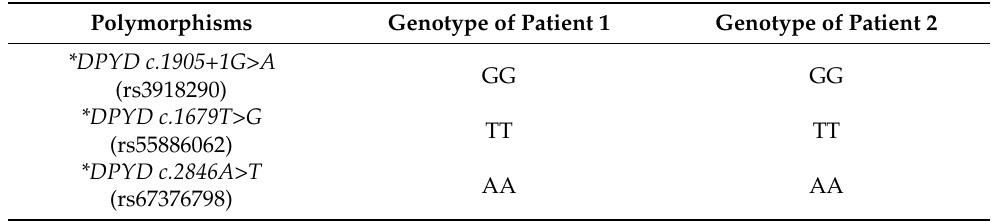
Table 2. The table shows the genotypes of patients 1 and 2 based on pharmacogenetic tests performed according to their chemotherapy regimens (CAPOX and capecitabine, respectively). The screening results of the recommended DPYD -SNPs (marked with an asterisk) are reported together with those of other polymorphisms proposed as potential predictive factors of FP-related